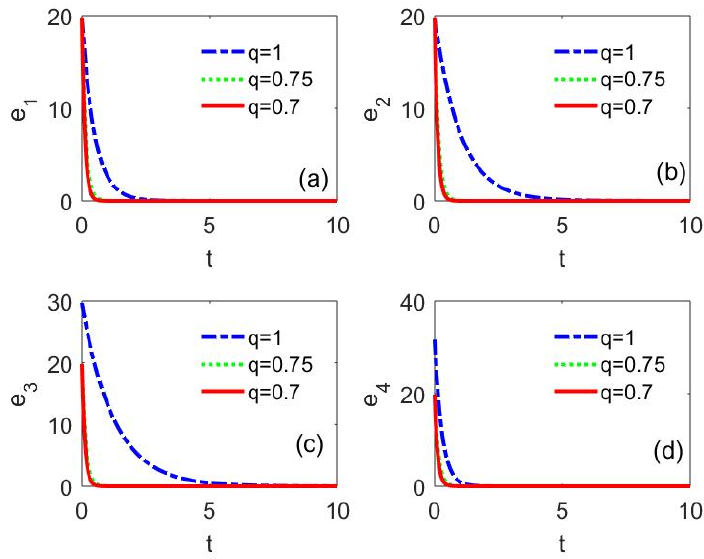
Figure 9. Time series of error system (17) with the order q = 1, q = 0.75, and q = 0.7. In order to see the comparison of the time histories of the drive system and the response system more visually and to further verify the synchronization, the fractional order q is chosen to be 0.75 and the time series of systems (12) and system (13) are plotted in the same figure, as shown in Figure 10. The green line in the figure represents the time series of the drive supply chain system under its initial conditions, and the yellow line represents the time series of the response supply chain system under its initial conditions, and the comparison reveals that the time series of the two systems overlap after t = 1.6 as time grows. Again, it shows that the designed synchronization controllers are effective and can synchronize the two systems.